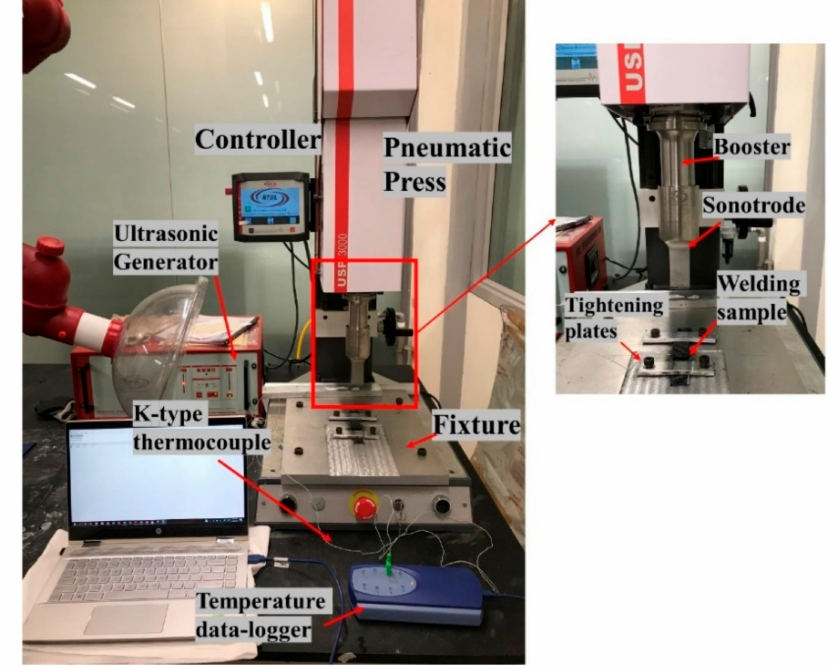
Figure 6. Ultrasonic welding machine test